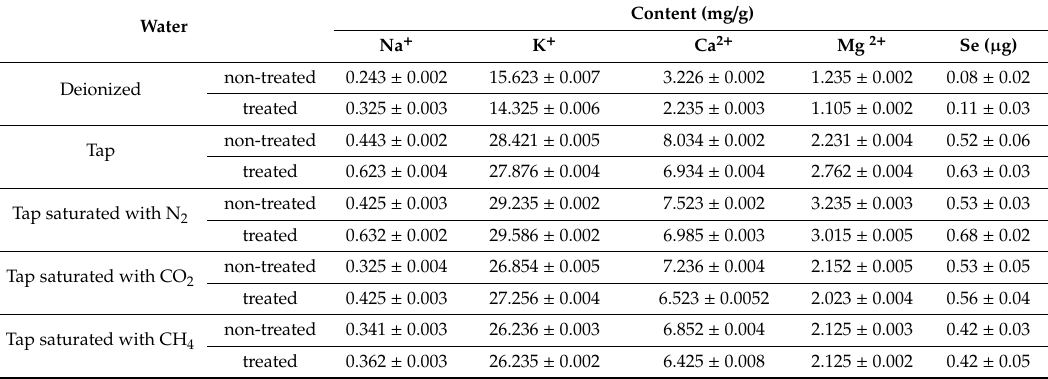
Table 4. Bioaccumulation of cations in cress watered with particular kinds of